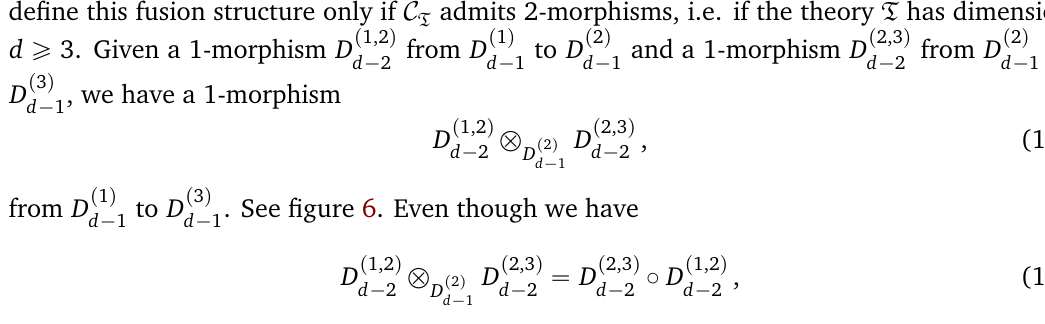
Figure 6: Here we have rotated the figure 5, while keeping the time direction going from bottom to top. The fusion of D p 1,2 q operation on 1-morphisms. Such a monoidal operation is labeled by objects, as in equation